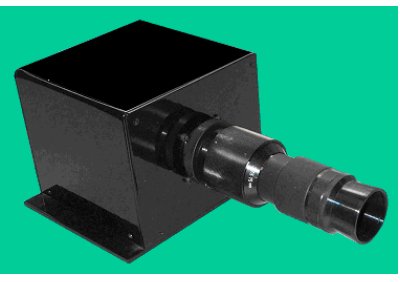
Figure12. The contour of camera. Figure 12. The contour of camera.